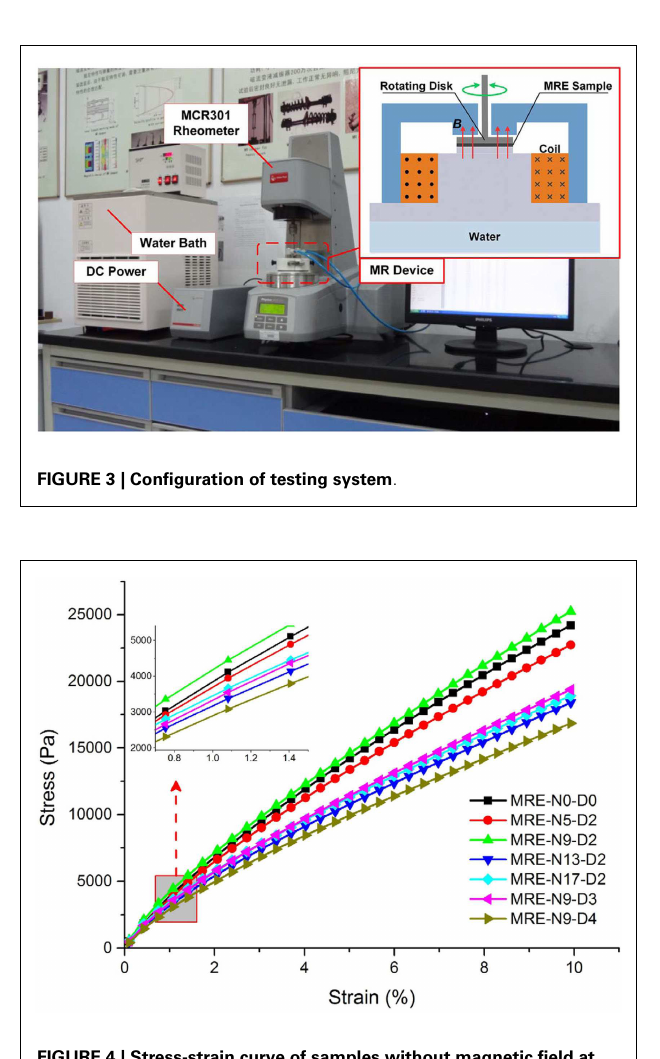
FIGURE 4 | Stress-strain curve of samples without magnetic field at 10Hz .